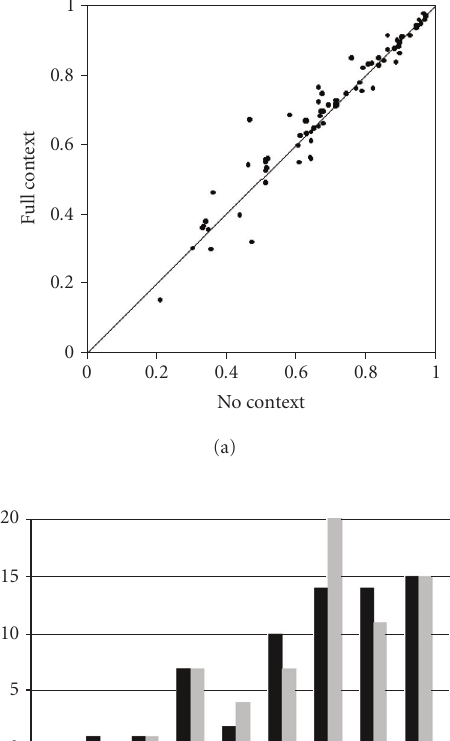
one position from the given residue, that is, the left con- text for the substitution C (cid:1)→ D is amino acid C or H , and the right context consists of D or C .